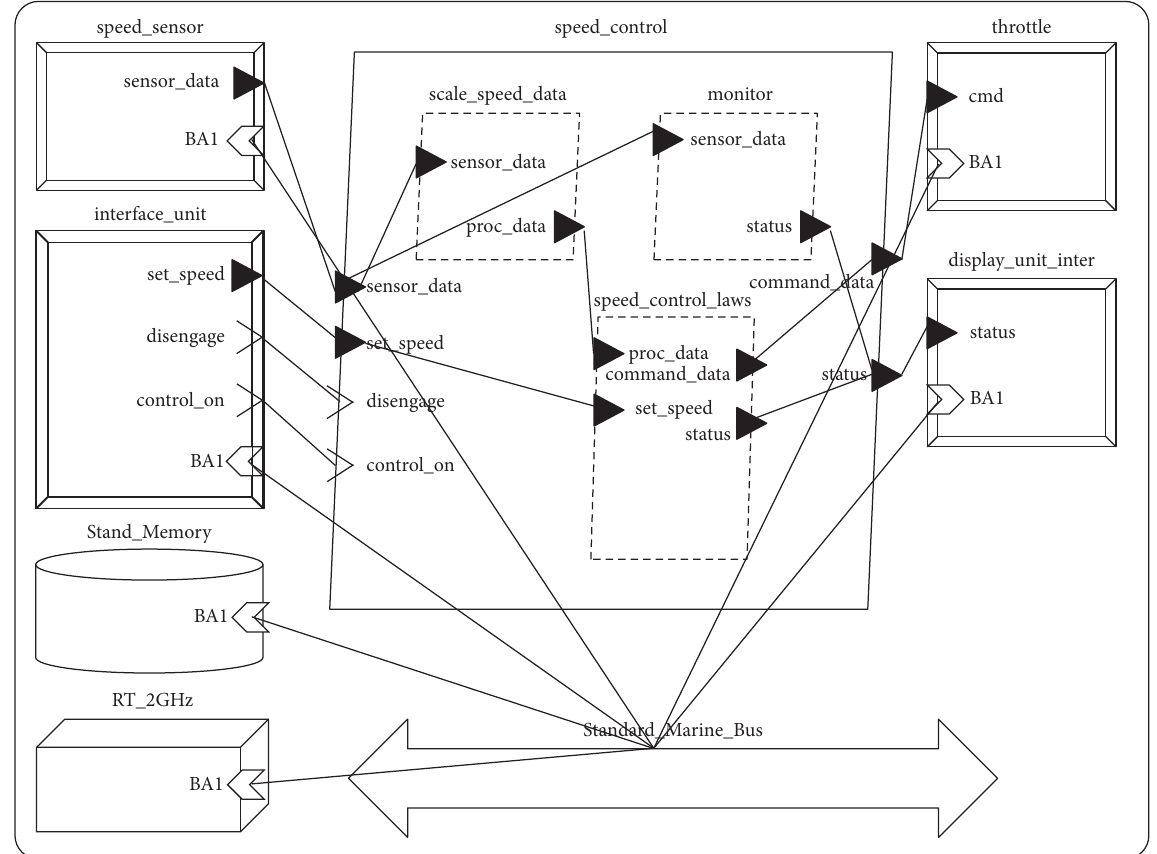
Figure 2: PBA Speed Control Unit without error